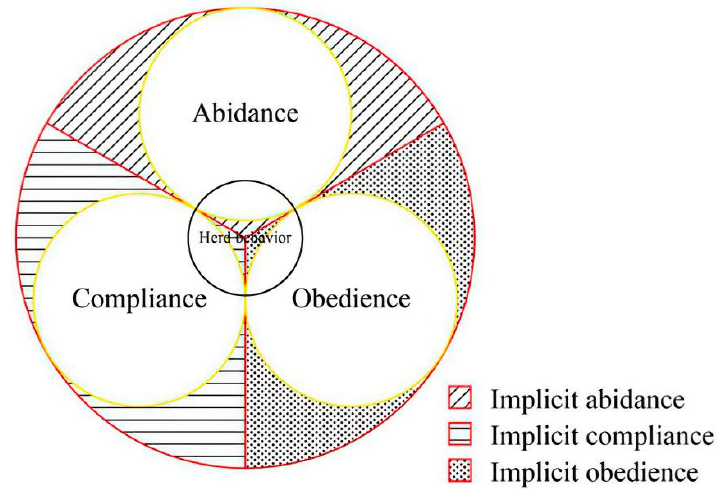
Figure 1. Types of conformity and their relationship.